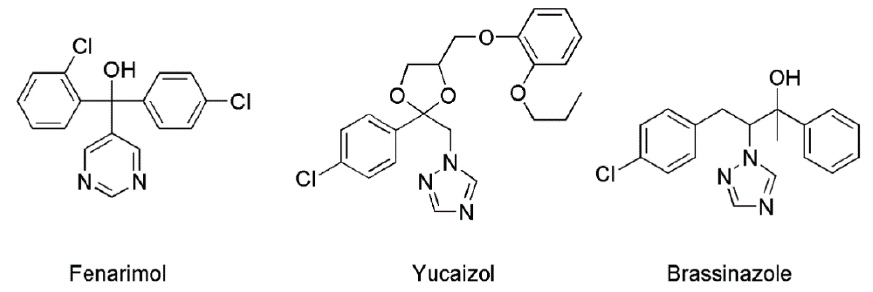
Figure 2. Chemical structures of BR biosynthesis inhibitors.